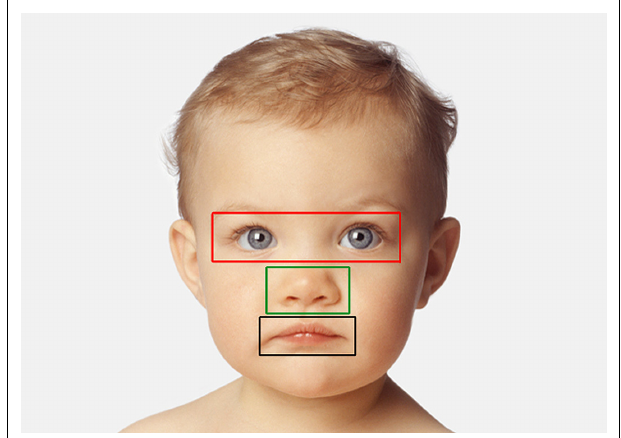
FIGURE 3 | Example ofAOIs for one face (human infant). AOIs include three separate feature regions: eye (red), nose (green), and mouth (black).